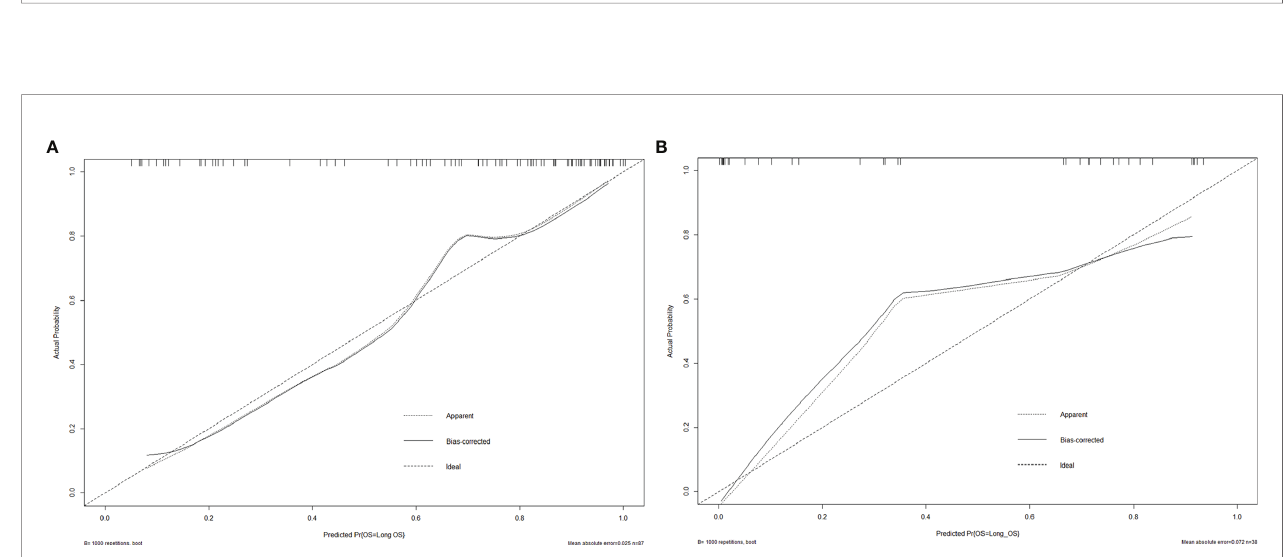
FIGURE 5 | The AUCs of the radiomics nomogram for the training cohort (A) and validation cohort (B) . The results demonstrated that the radiomics nomogram performed well in both groups with favorable sensitivity and speci fi